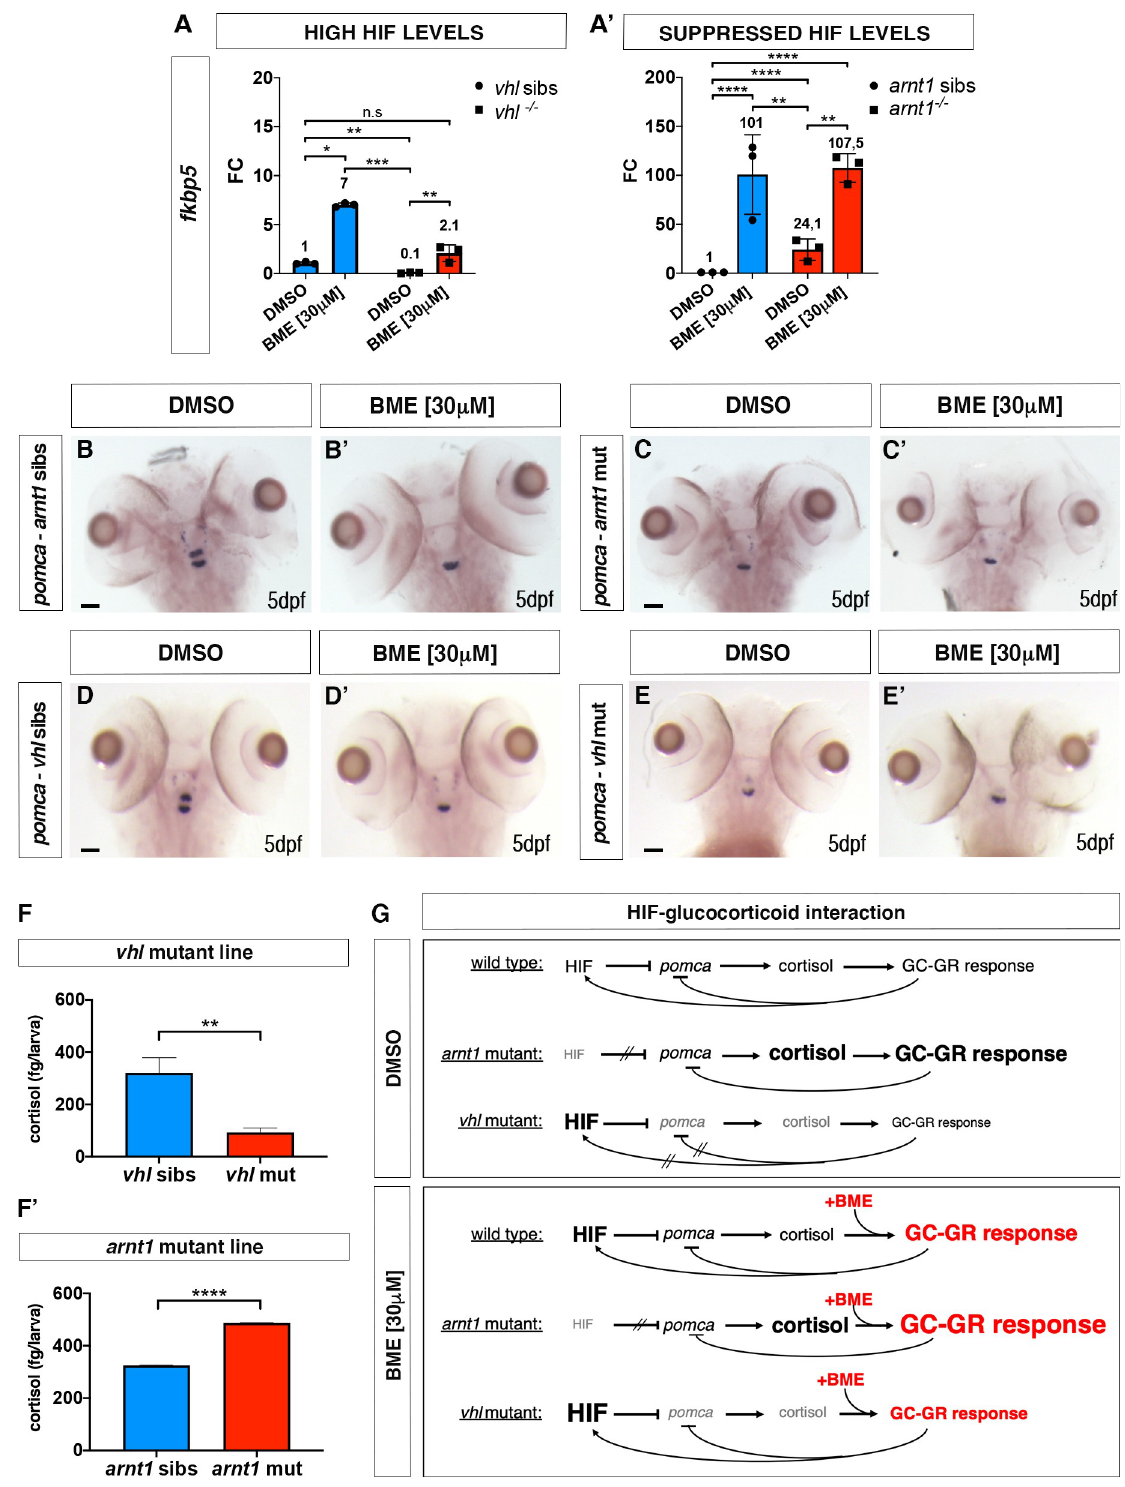
Fig 2. HIF signalling inversely correlate with GC transcriptional activity and cortisol biosynthesis. A. Schematic view of RTqPCR analysis on fkbp5 expression performed on the vhl +/- ( phd3:eGFP ) and the arnt1 +/- ( phd3:eGFP ) mutant lines at 5 dpf:. Upregulated (in vhl -/- ) HIF signalling repressed Gr activity, whereas arnt1 loss of function derepressed it. Statistical analysis was performed on ΔΔ Ct values, whereas data are shown as fold change values for RTqPCR analysed samples; ordinary Two-way ANOVA followed by Dunnett’s multiple